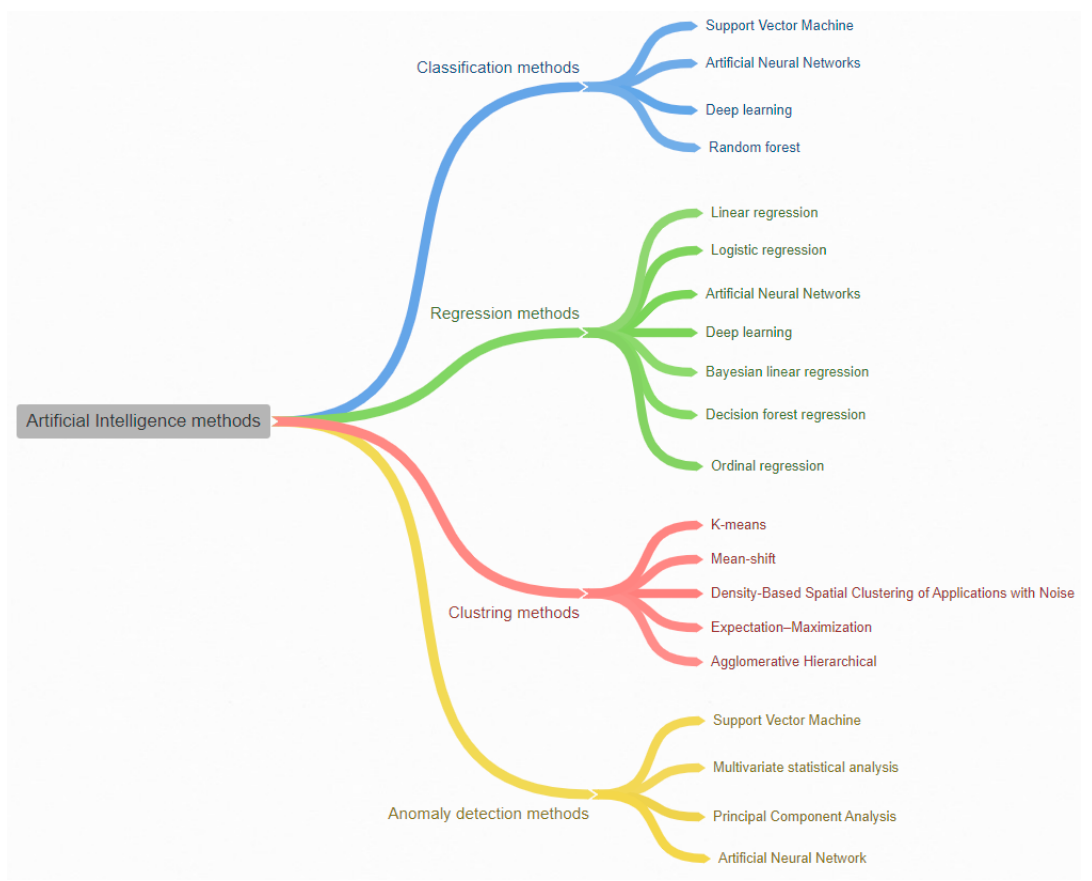
Figure 7. Most well-regarded AI methods for classification, regression, clustering, and anomaly de- tection.